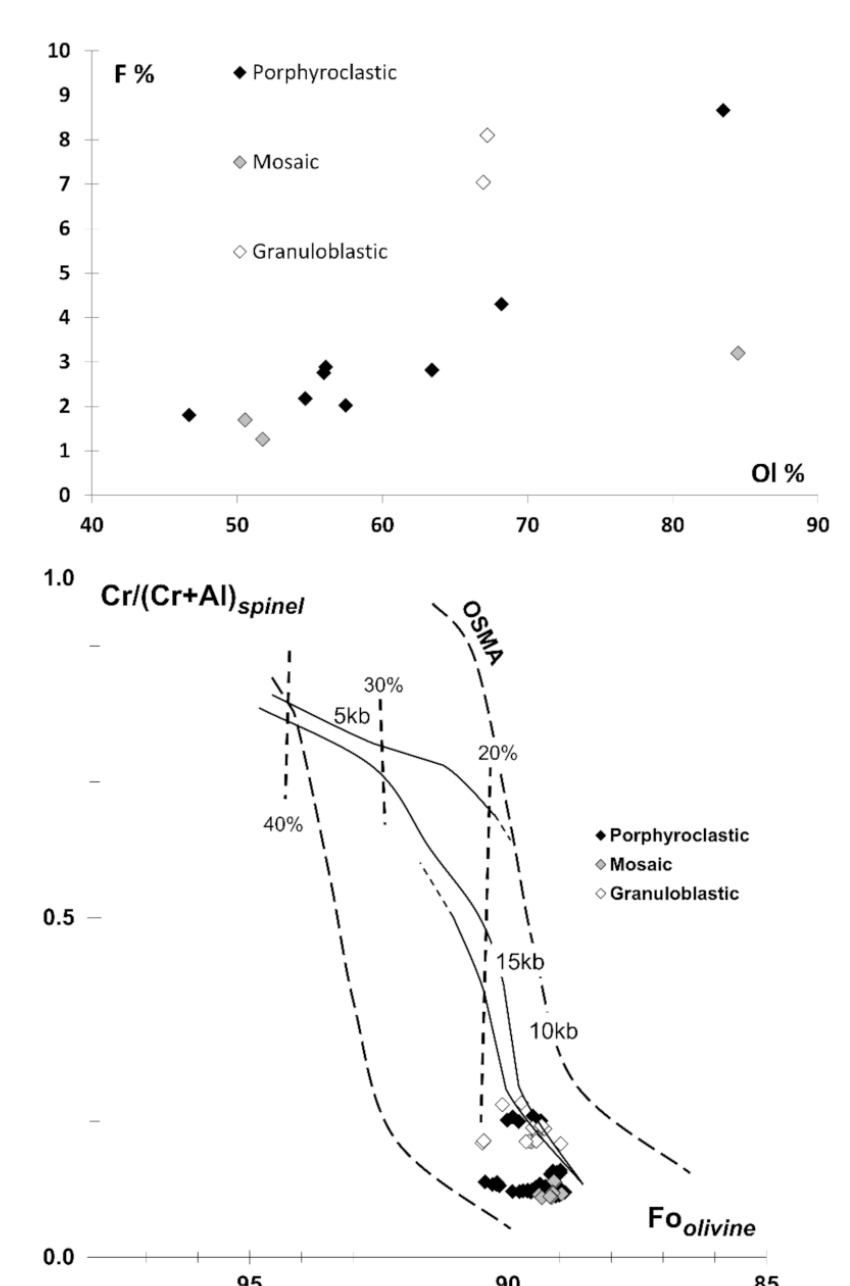
Figure 8. F% estimated with the equation of Warren [63] vs. Olivine modal abundance; OSMA diagram from Arai [64]: Cr/(Cr + Al) in spinel vs. Fosterite content in